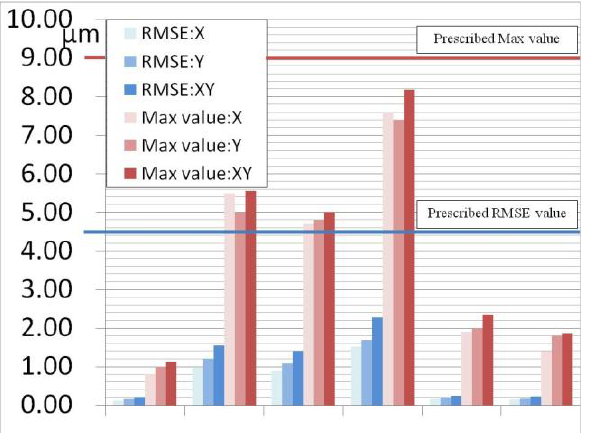
Figure 10. image coordinates residuals of each block